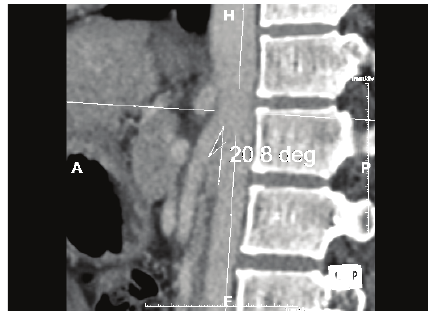
Figure 1: Sagittal contrast CT of our patient showing a mesoaortic angle of 20.8 degrees.